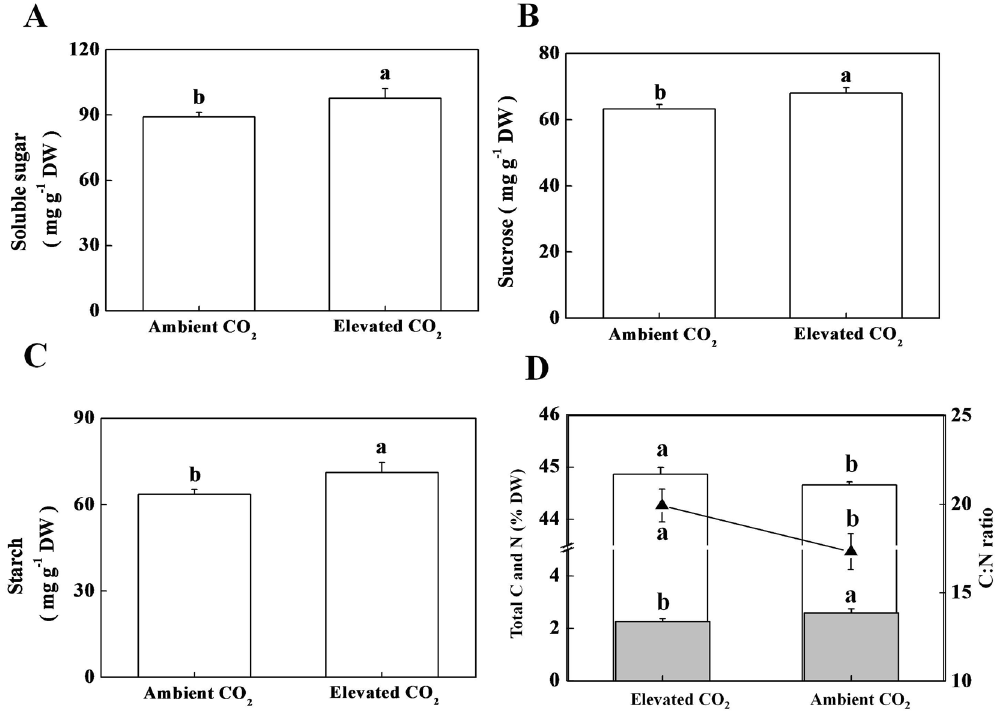
Figure 3. Effect of ambient (380 µ mol mol − 1 ) or elevated CO 2 concentration (800 µ mol mol − 1 ) on carbohydrate, carbon and nitrogen concentration in tea leaves. ( A ) Soluble sugar concentration, ( B ) Sucrose concentration, ( C ) Starch concentration, and ( D ) Total carbon, total nitrogen and C:N ratio. Histograms with solid fill color ( ■ ) and without fill color ( □ ) represent total nitrogen and total carbon, respectively, while line graph (- ▲ -) represents C: N ratio. Leaf samples were harvested after exposure of tea plants to different concentrations of atmospheric CO 2 for 24 days. Data are the means of four replicates ( ± SD). Mean denoted by different letters indicate significant differences between the treatments ( P < 0 . 05